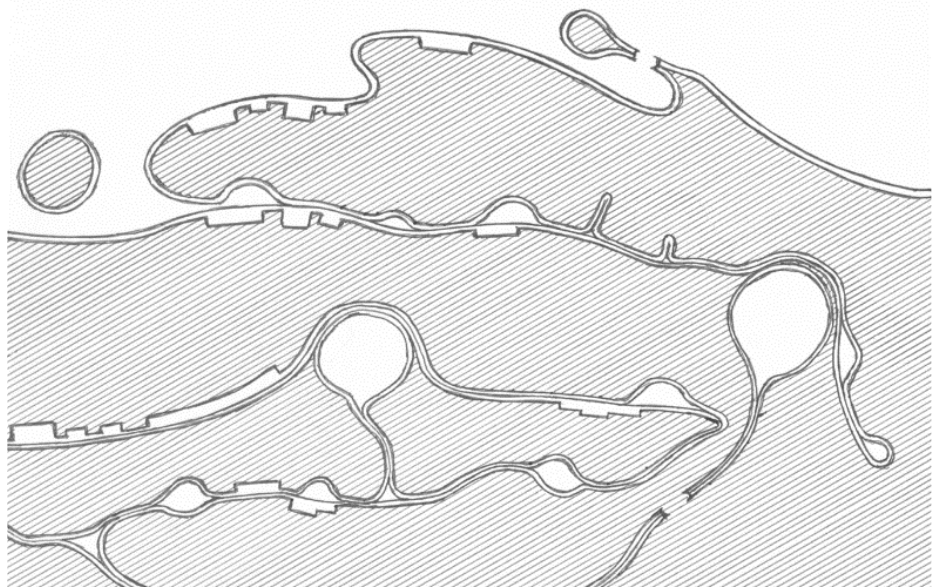
Figure 1. Turbulence in the liquid, causing entrainment of the surface oxide, creating bifilms and bubbles.